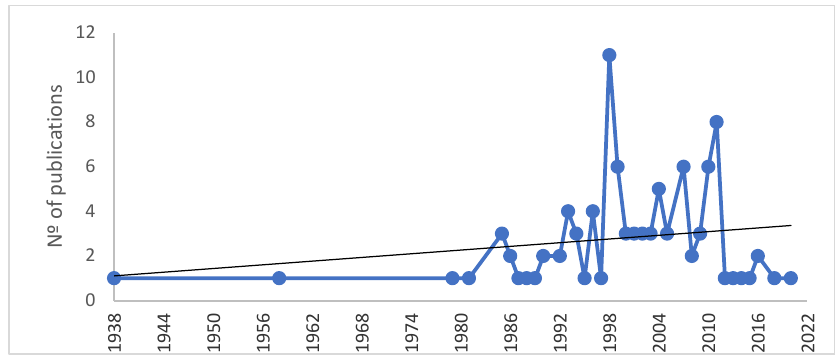
Figure 2. Pattern of distribution of top-cited articles (number of articles per year).